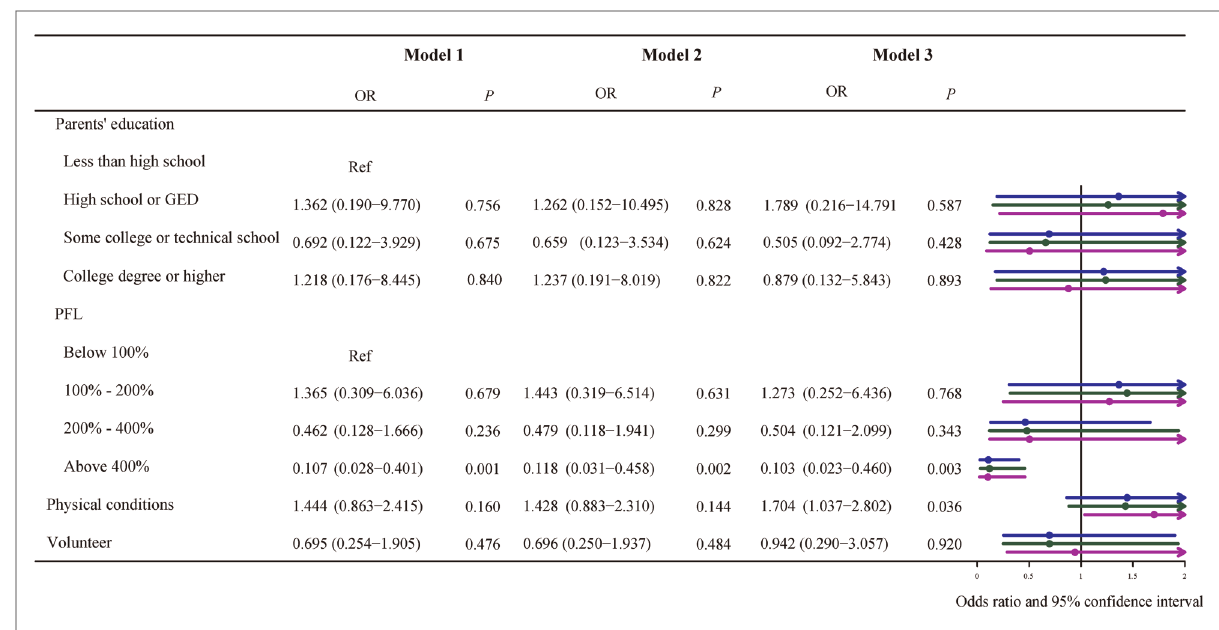
FIGURE 5 Odds ratios of children with moderate/severe symptoms of epilepsy. Model 1 was the crude model, Model 2 adjusted for sex, age, and race, and Model 3 adjusted for sex, age, race, use of cigarets, cigars, or pipe tobacco inside, afterschool activity, and physical